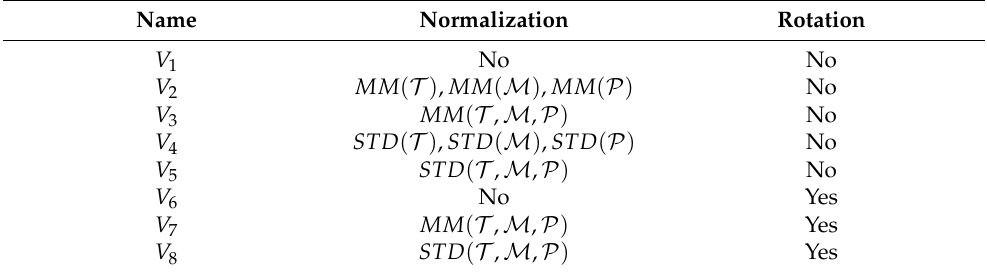
Table 1. Version specifications: Influence of the normalization and the local navigation frame